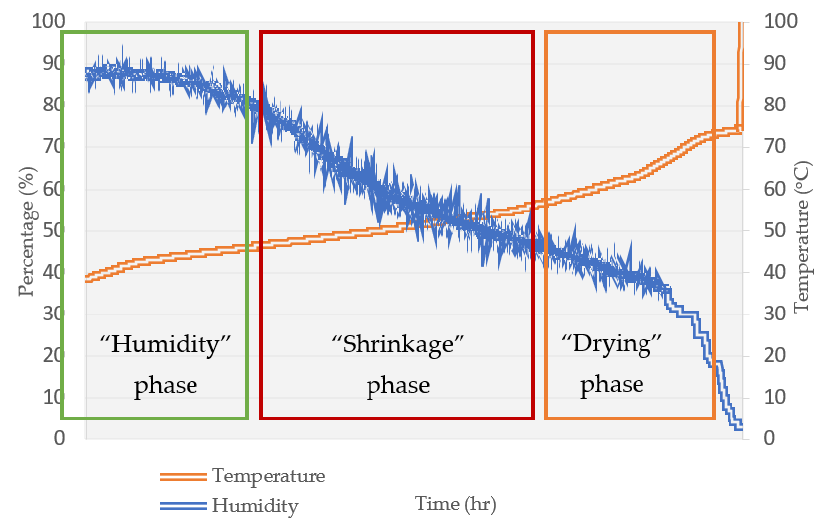
Figure 5. Drying circle and each of three (3) phases followed for the tests.